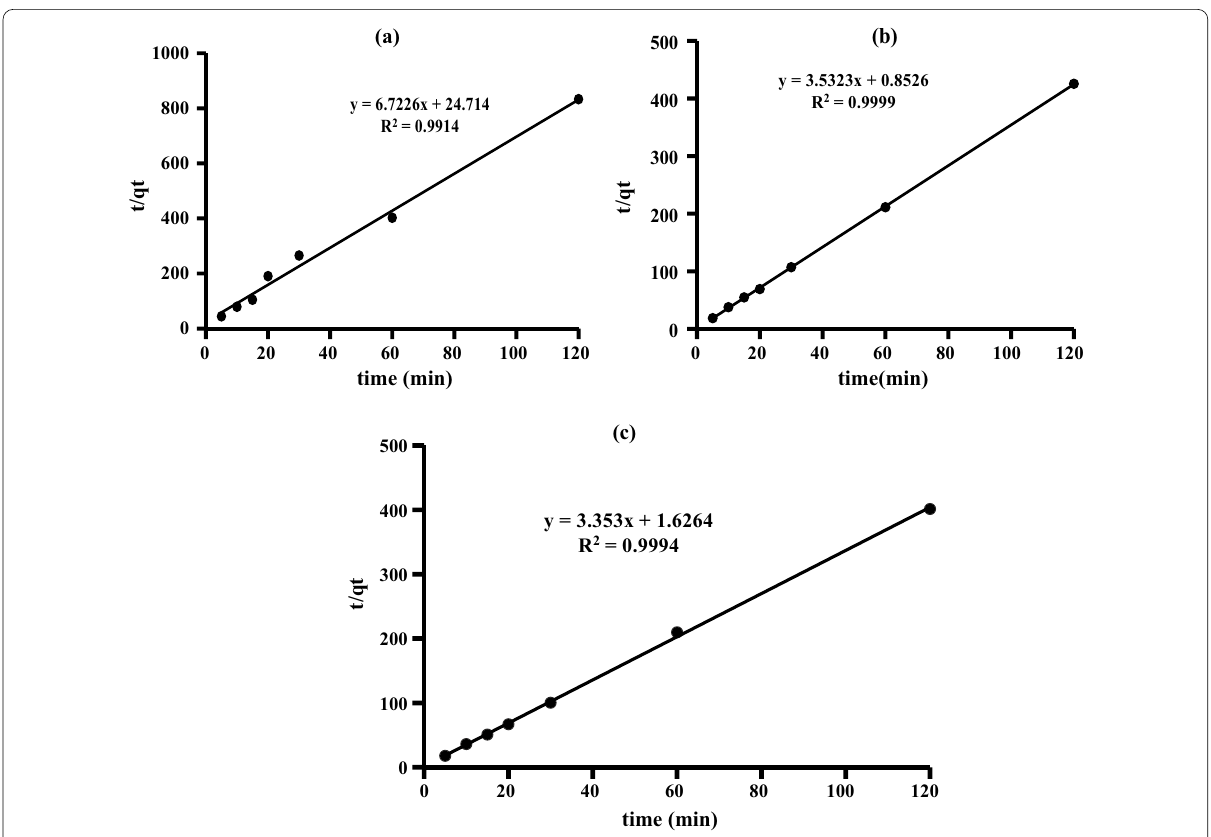
Fig. 14 Second‑order module of copolymer ( a ), aniline graft ( b ) and 2‑chloroaniline graft ( c